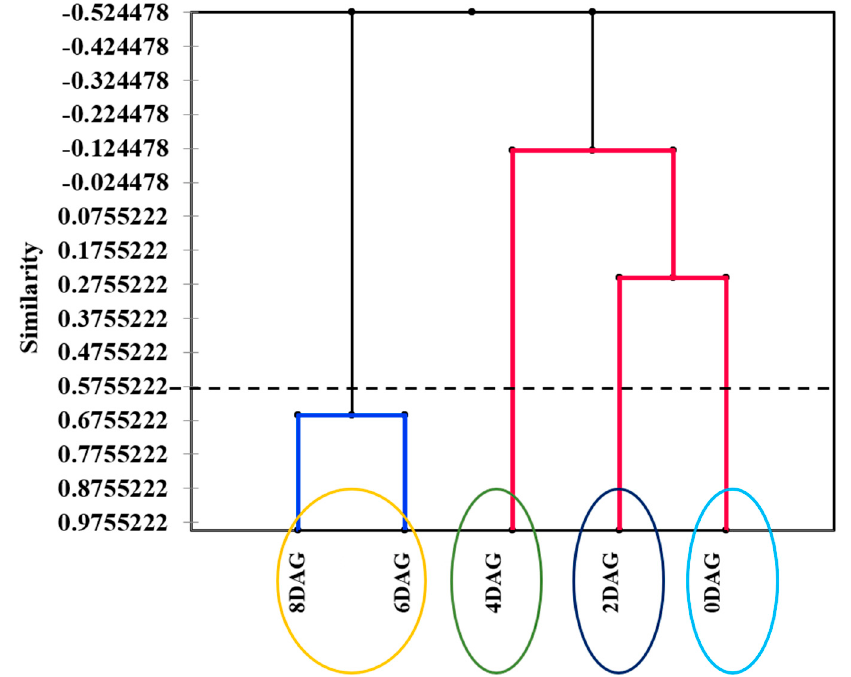
Figure 3. Dendrogram (similarity mode of agglomerative hierarchical clustering) of germinated sacha inchi seeds at different germination times ( p ≤ 0.05). DAG, days after germination.